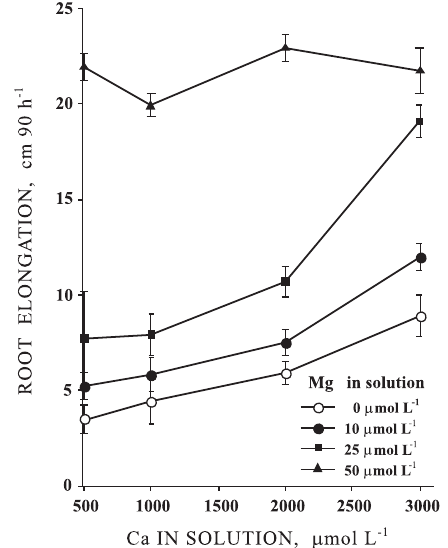
Figure 5. Relative root elongation of soybean cultivar Confiança as a function of increasing Ca and Mg in solution (pH 4.5), in the presence of 10 μ mol L -1 Al. Error bars represent standard error (n =